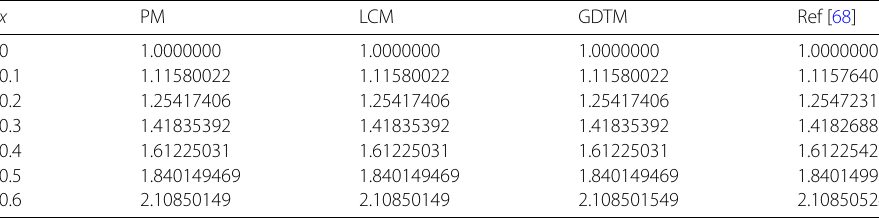
Table 6 Numerical results of Example 5 for ν 4 = 3.75